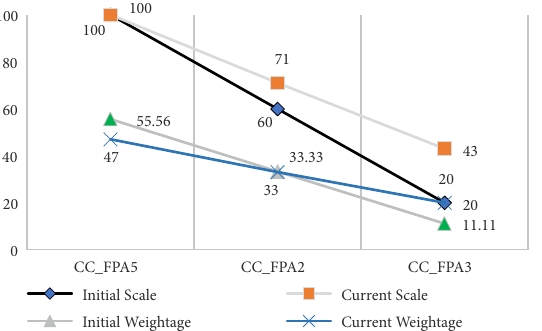
Figure A5. Model modification for sub-criteria of MPC Figure A6. Model modification for sub-criteria of QAS